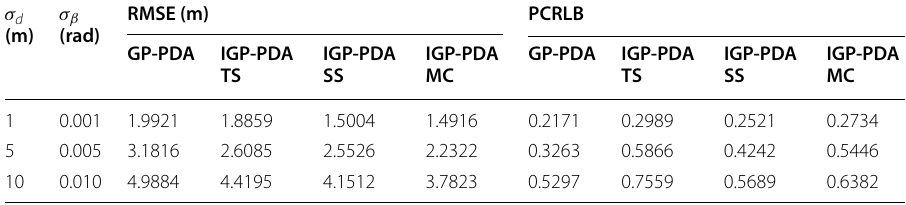
Table 5 Effect of measurement noise on contour estimates RMSE and PCRLB in the second scenario σ d σ β (m) (rad)